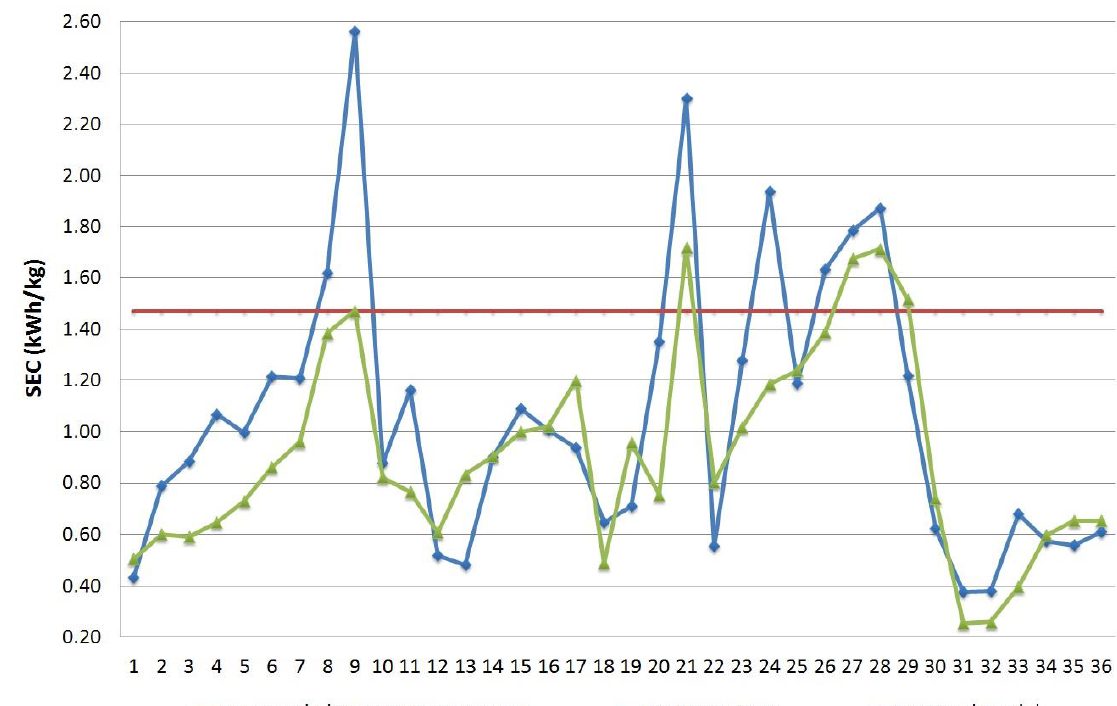
Figure 2. SEC comparison of the model’s results, measured values, and the EcoInvent data.